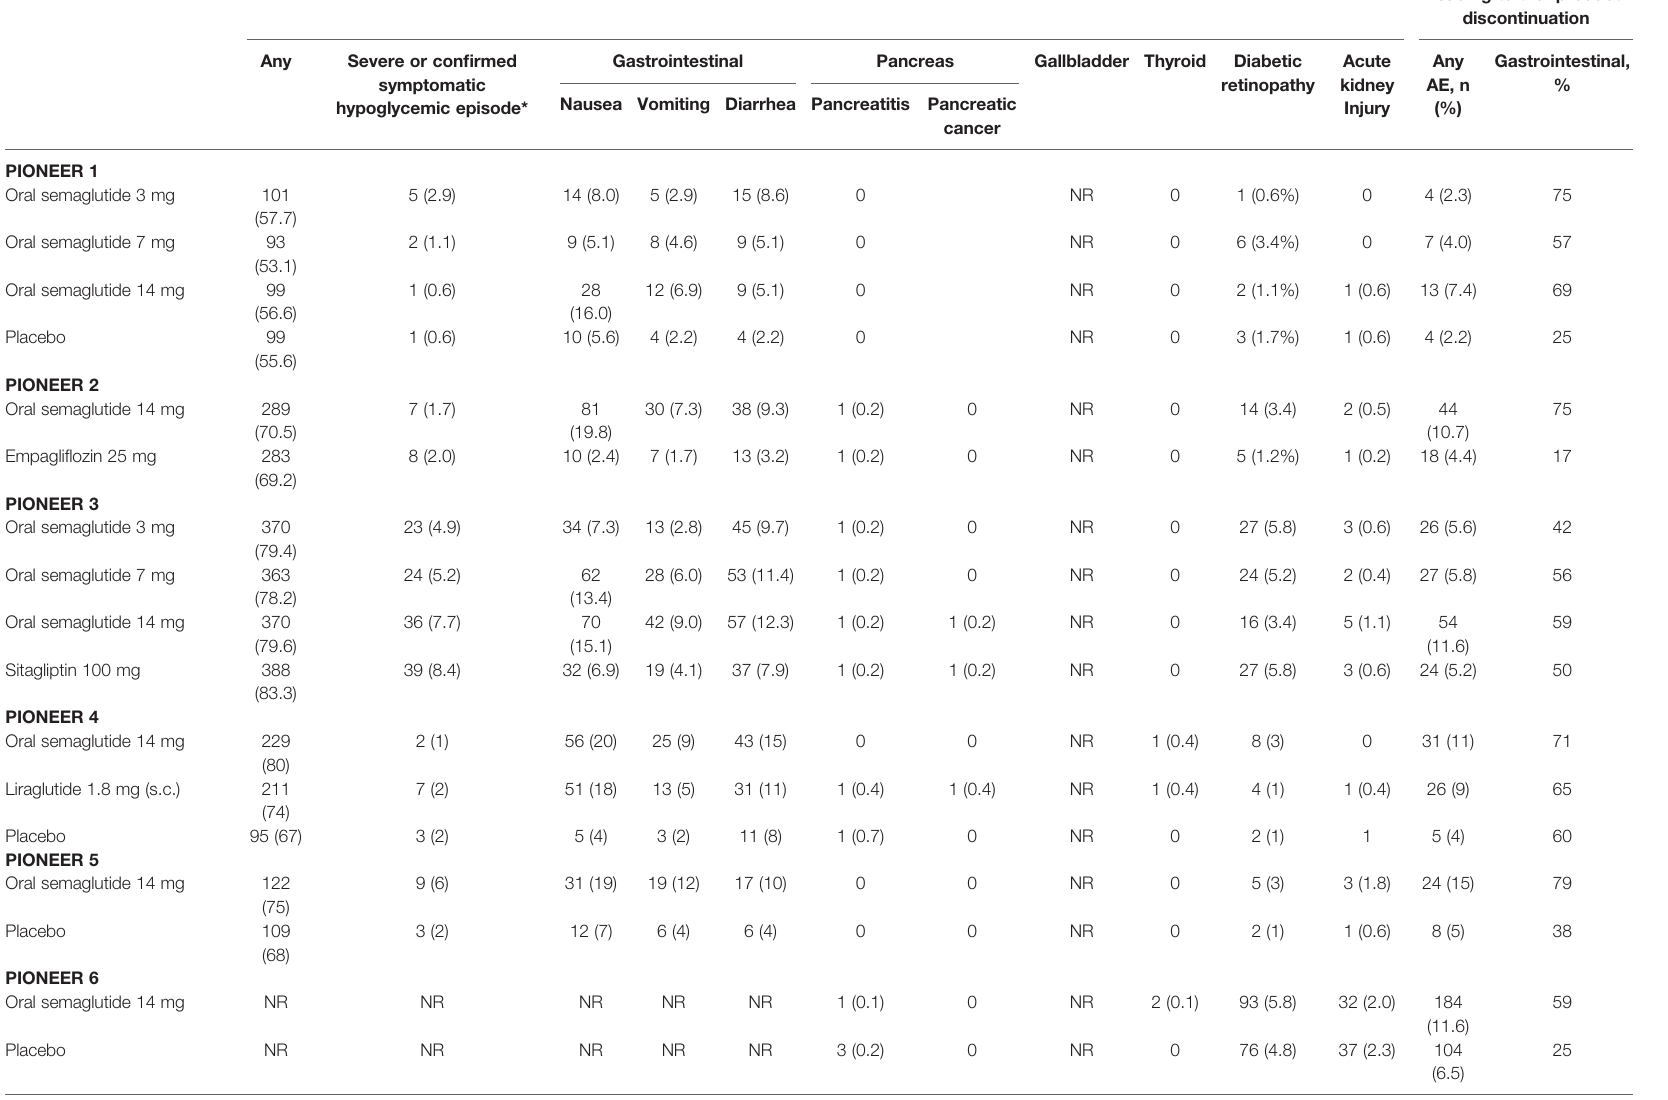
TABLE 2 | Adverse effects and safety risks in phase 3 trials (10 –